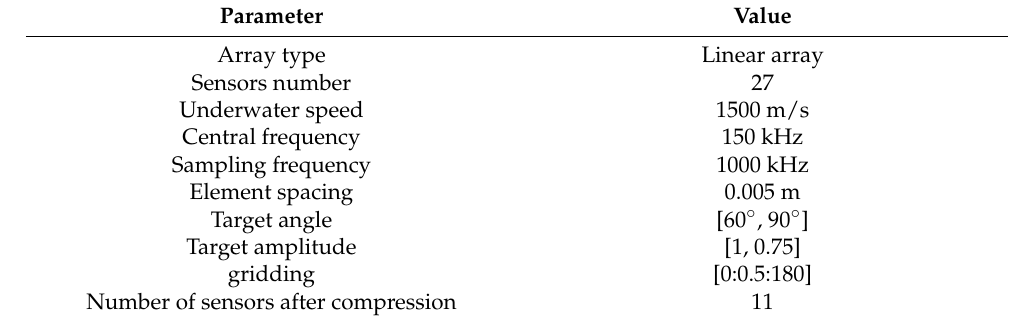
Table 1. Simulation parameters.